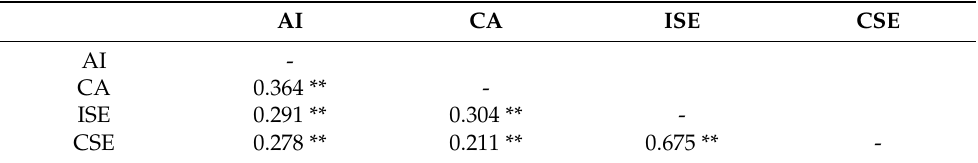
Table 3. Correlation